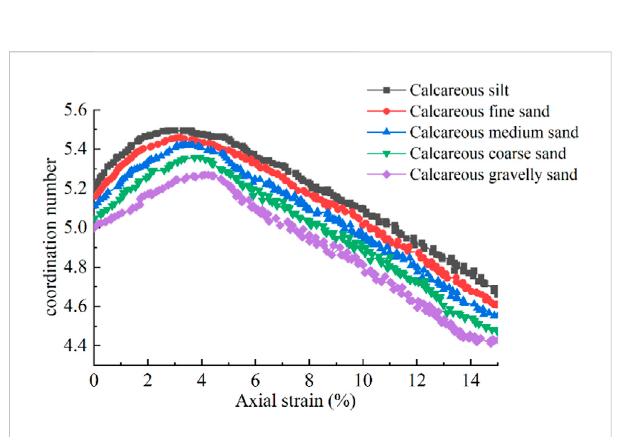
FIGURE 15 Relationship between the coordination number and axial